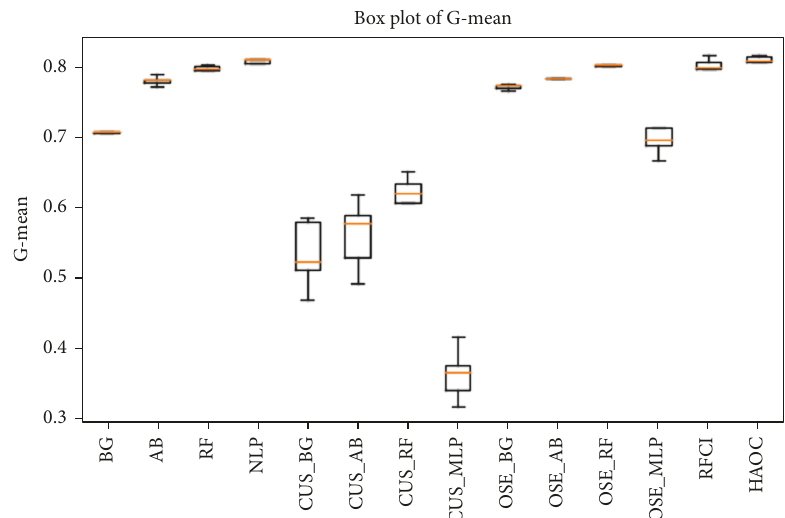
Figure 9: The box plot in terms of G-mean of experimental approaches for KRBDS in five